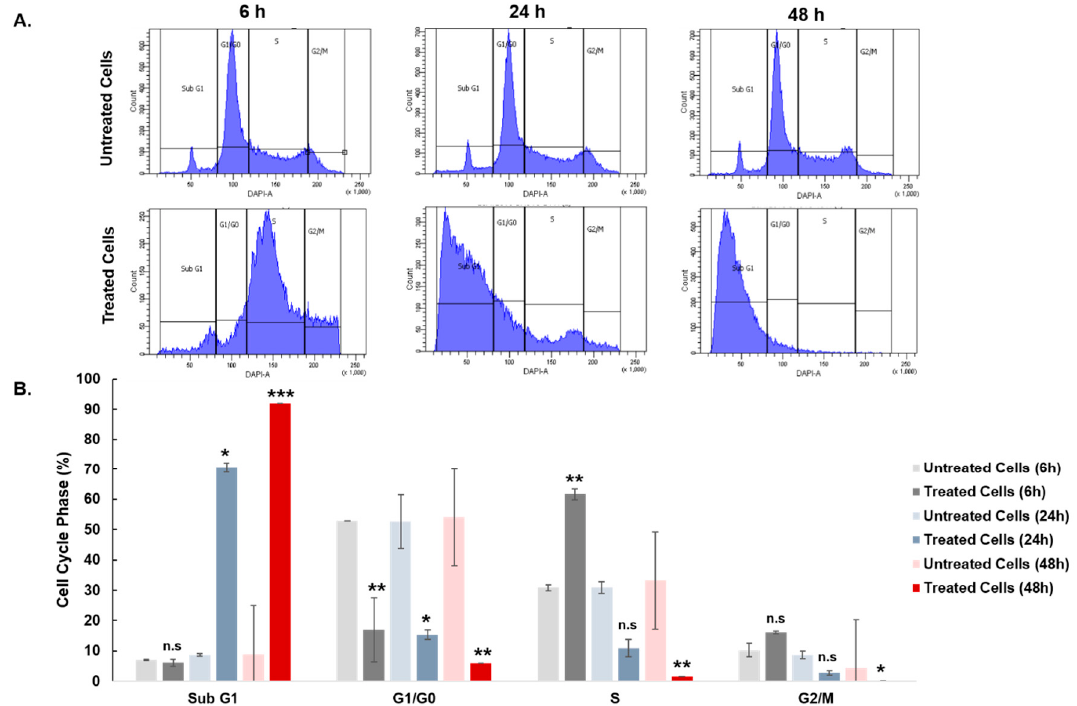
Figure 7. The cell cycle distribution of untreated and curcuminoid-treated (30 µM) SKOV-3 cells for the analysis of time-dependent effects. ( A ) Flow cytometry analysis of the cell population of SKOV-3 cells either untreated or treated with 30 µM curcuminoids for various time periods. ( B ) The percentage of cell cycle phase in response to curcuminoids (30 µM) at different treatment periods. *, **, and *** indicate statistical significance (p < 0.05, p < 0.01, and p < 0.001, respectively).